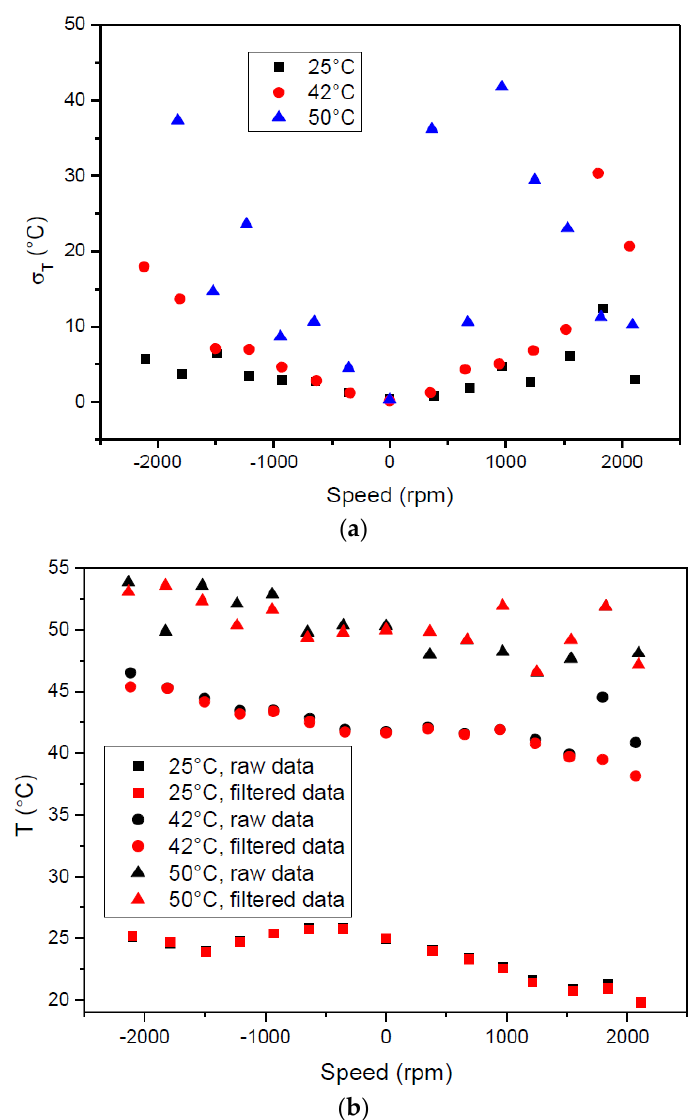
Figure 11. ( a ) Standard deviation and ( b ) temperature measured at different rotation speeds. Black data points: values calculated with all frequency readings. Red data points: values calculated with frequency readings that fall within the standard deviation.